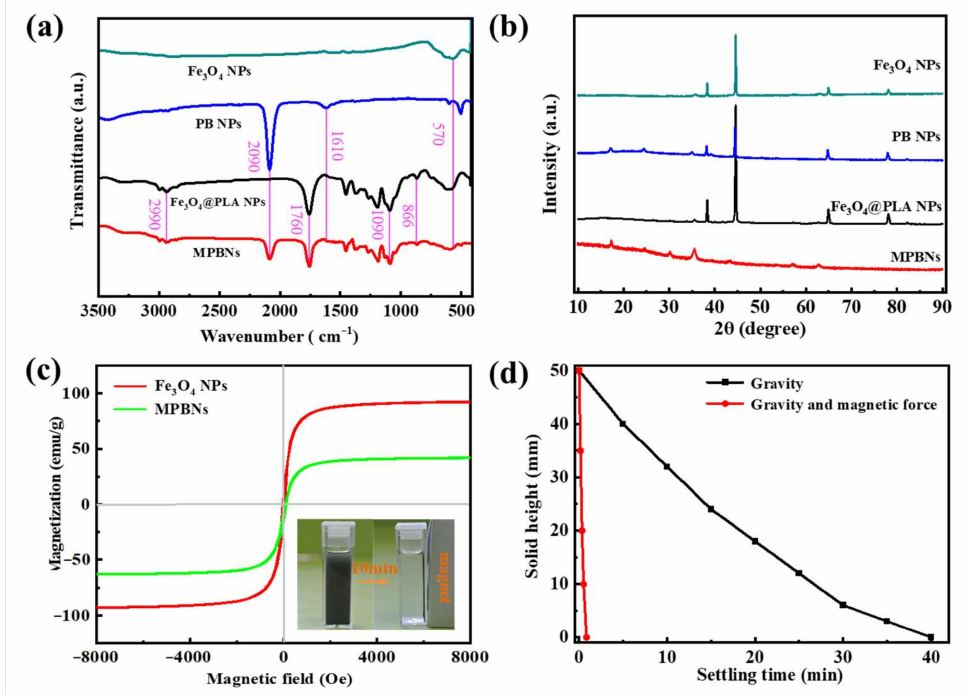
Figure 4. ( a ) FT-IR spectrum and ( b ) XRD patterns of PB NPs, Fe 3 O 4 NPs, MPBNs, and Fe 3 O 4 @PLA NPs; hysteresis curves of Fe 3 O 4 NPs and MPBNs; ( c ) photographs of MPBN suspension before and after magnet adsorption; ( d ) the test of settlement property of MPBNs in